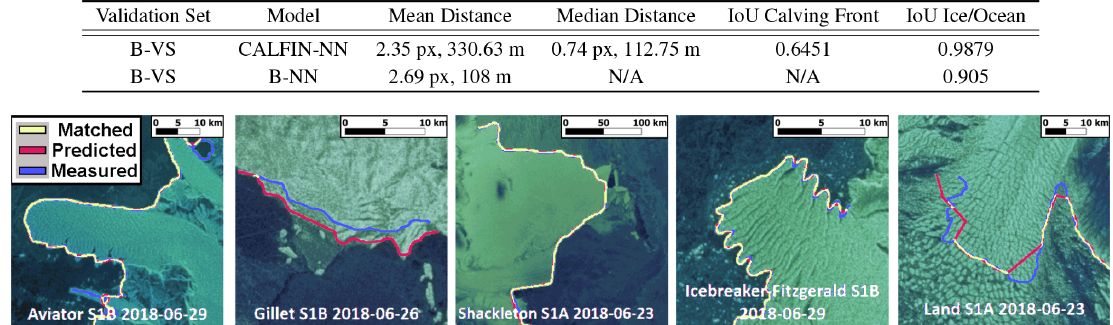
Figure 12. B-VS validation output results. Similar to Z-NN, B-NN uses a high-resolution input (768 × 768) relative to CALFIN-NN (224 × 224), which skews the mean pixel distance comparison in CALFIN-NN’s favor. See Figs. S11–S12 for full